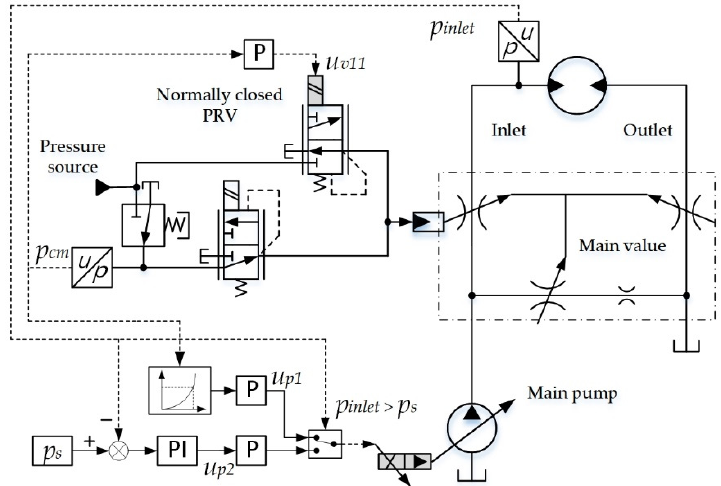
Figure 3. Schematic diagram of motor acceleration control (single-swing).